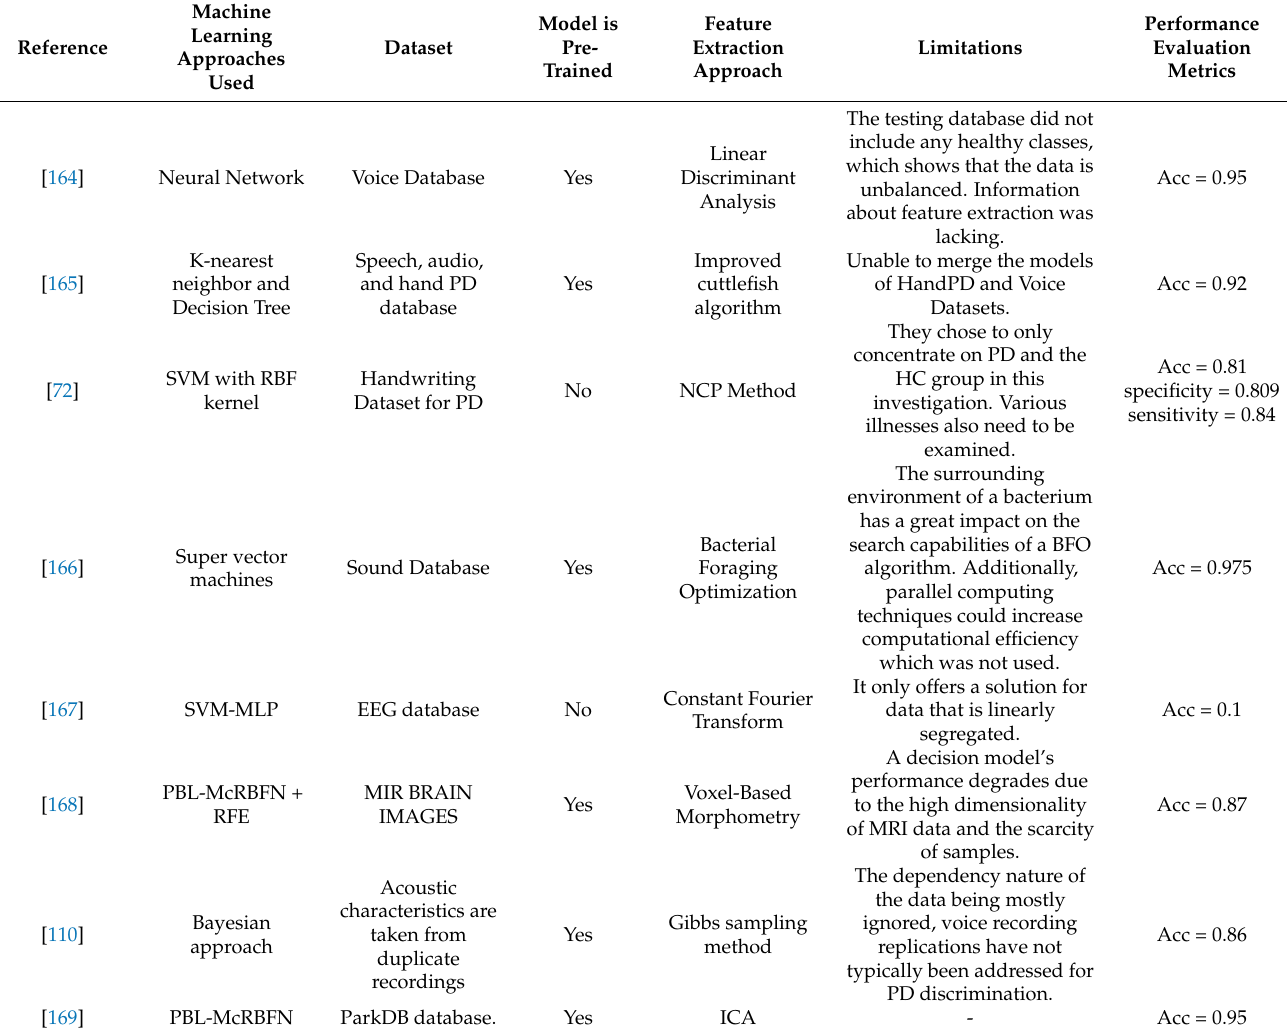
Table 5. A Summary of Studies on Machine Learning Models for Parkinson’s Disease